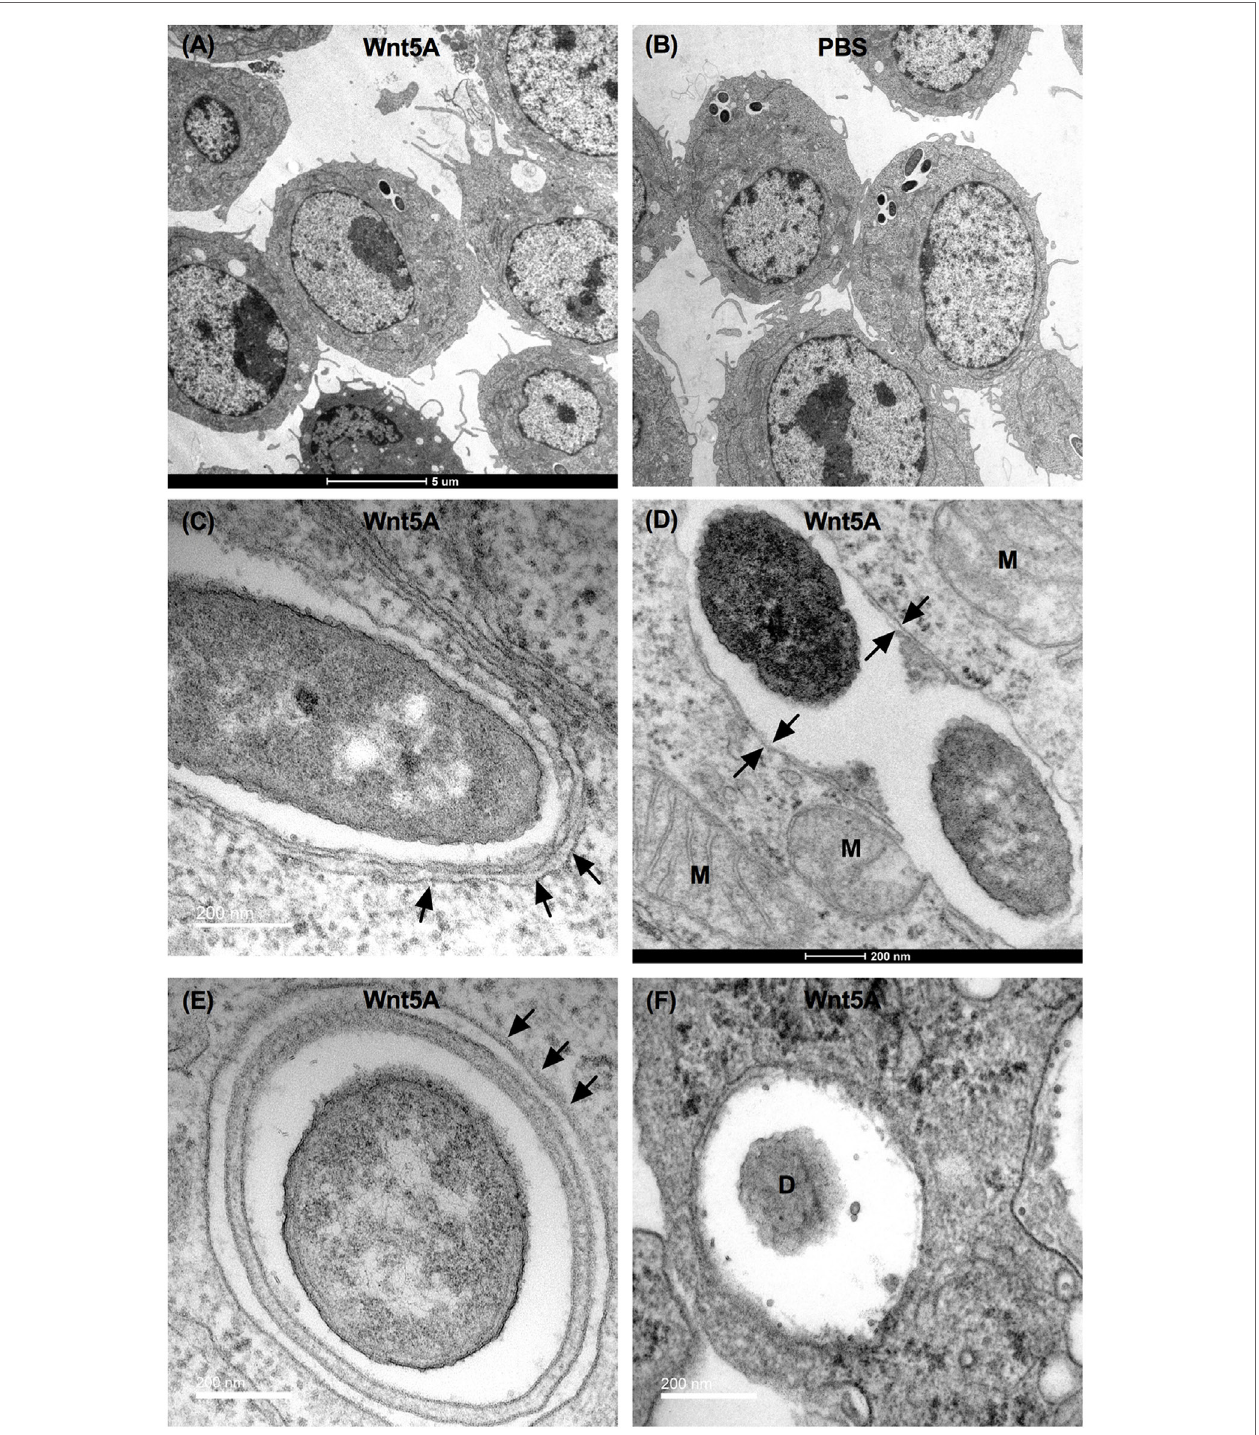
FigUre 8 | Transmission electron microscopy (TEM) demonstrating Wnt5A-induced autophagosome like moieties and bacterial killing after PA infection. Lesser number of bacteria present in Wnt5A-treated cells compared to PBS-treated cells (a,B) . Arrows point to double membrane or multilamellar structures encapsulating bacteria in Wnt5A-treated macrophages (c–F) . M represents mitochondria. D denotes degraded